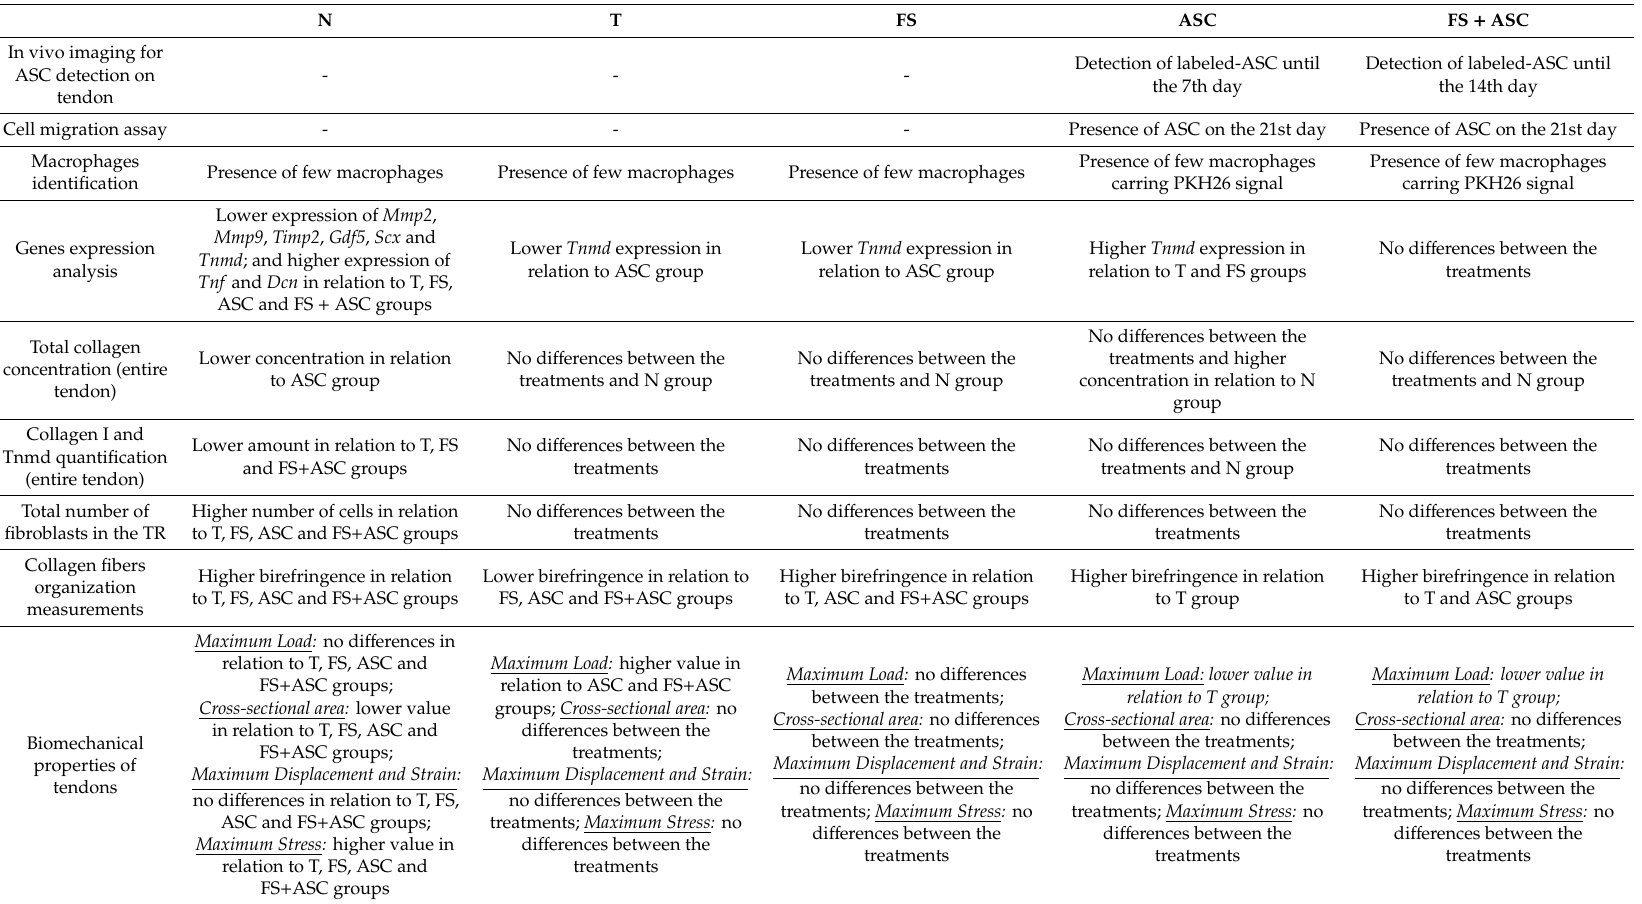
Table 3. Systematic overview table of